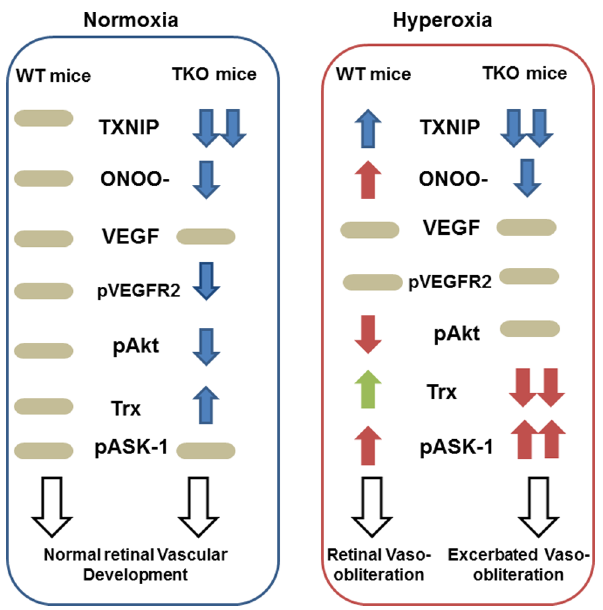
Figure 8. Representative diagram shows the impact of TXNIP deletion on retina vasculature under both normoxia and hyperoxia. Under normoxia, retinas from TXNIP-deficient mice showed similar VEGF levels, less peroxynitrite (ONOO-) levels, less VEGF receptor-2 (pVEGFR2) activation and upregulated thioredoxin (Trx) that collectively lead to normal vascular development in comparison to WT mice. Under hyperoxia, retinas from WT mice showed higher peroxynitrite formation, less survival Akt activation (pAkt) and upregulated proapoptotic signal of ASK-1 resulting in vaso-obliteration. Retinas from TKO although showed less peroxynitrite levels and maintained Akt activation, retinas experienced significant decreases in thioredoxin (Trx) that shift the balance of the ASK-1-Trx inhibitory complex and increases the activation of the proapoptotic ASK-1 pathway leading to exacerbated vasoobliteration compared to